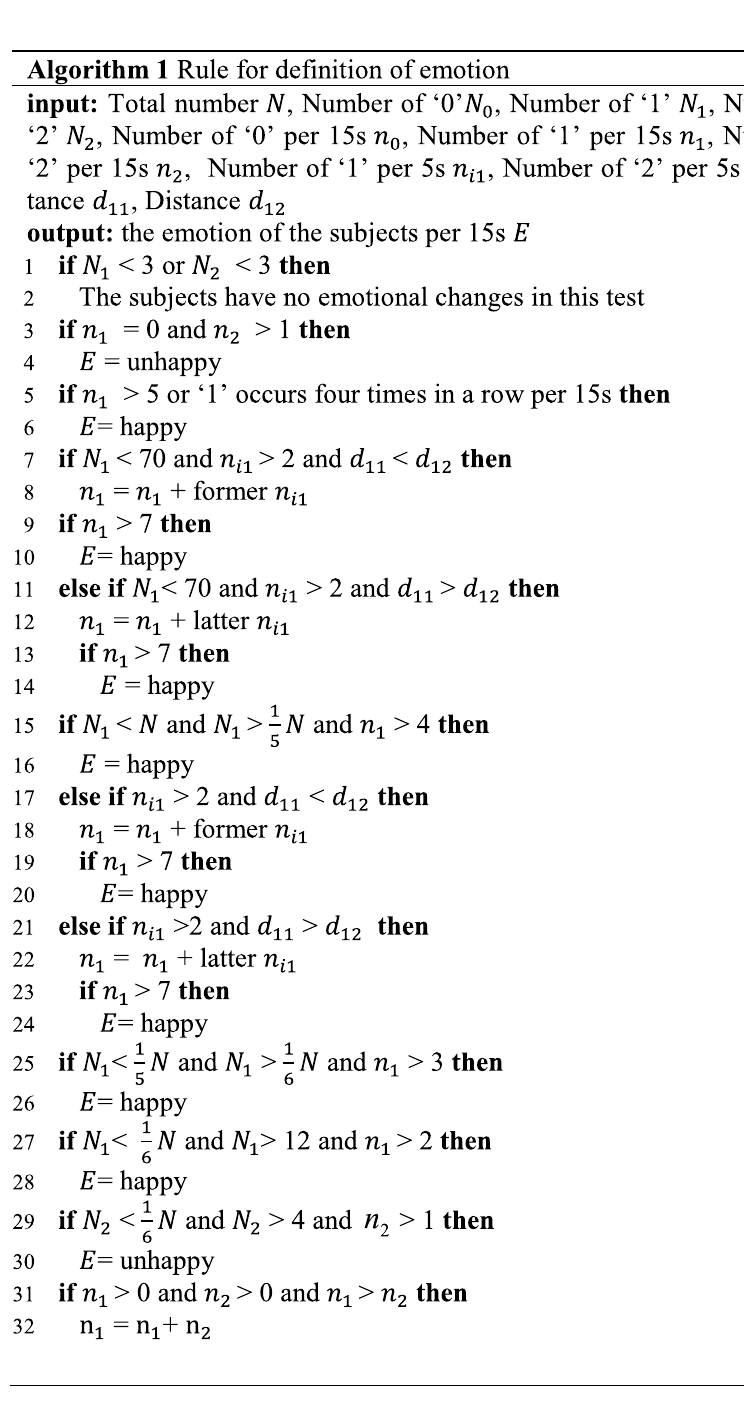
Where N represents the total number of expressions per second in the video. N 0 , N 1 , N 2 respectively indicate the number of corresponding expressions. n 0 , n 1 , n 2 are utilized to represent the number of different expressions in the video each 15 s. The number of ‘Happy’ and ‘Unhappy’ is defined as n i 1 and n i 2 of interval video in each 5 s to reduce